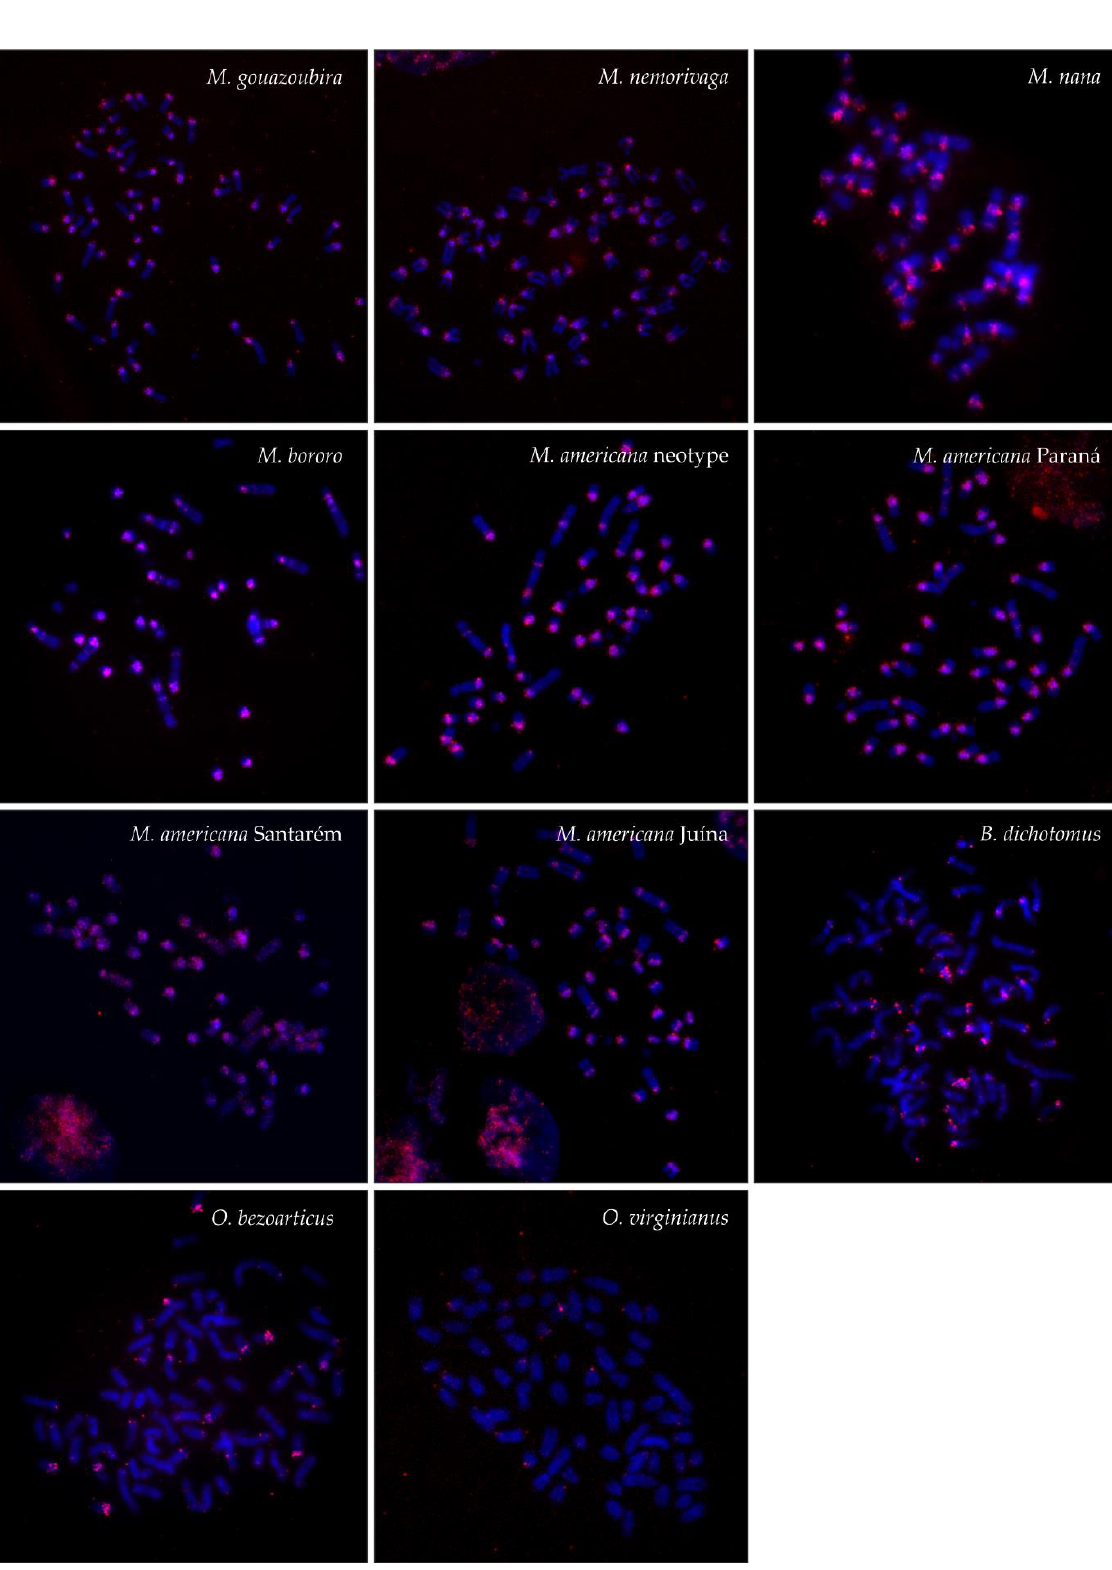
Figure 4. FISH patterns of the satIV (red) DNA probe in the analyzed species.